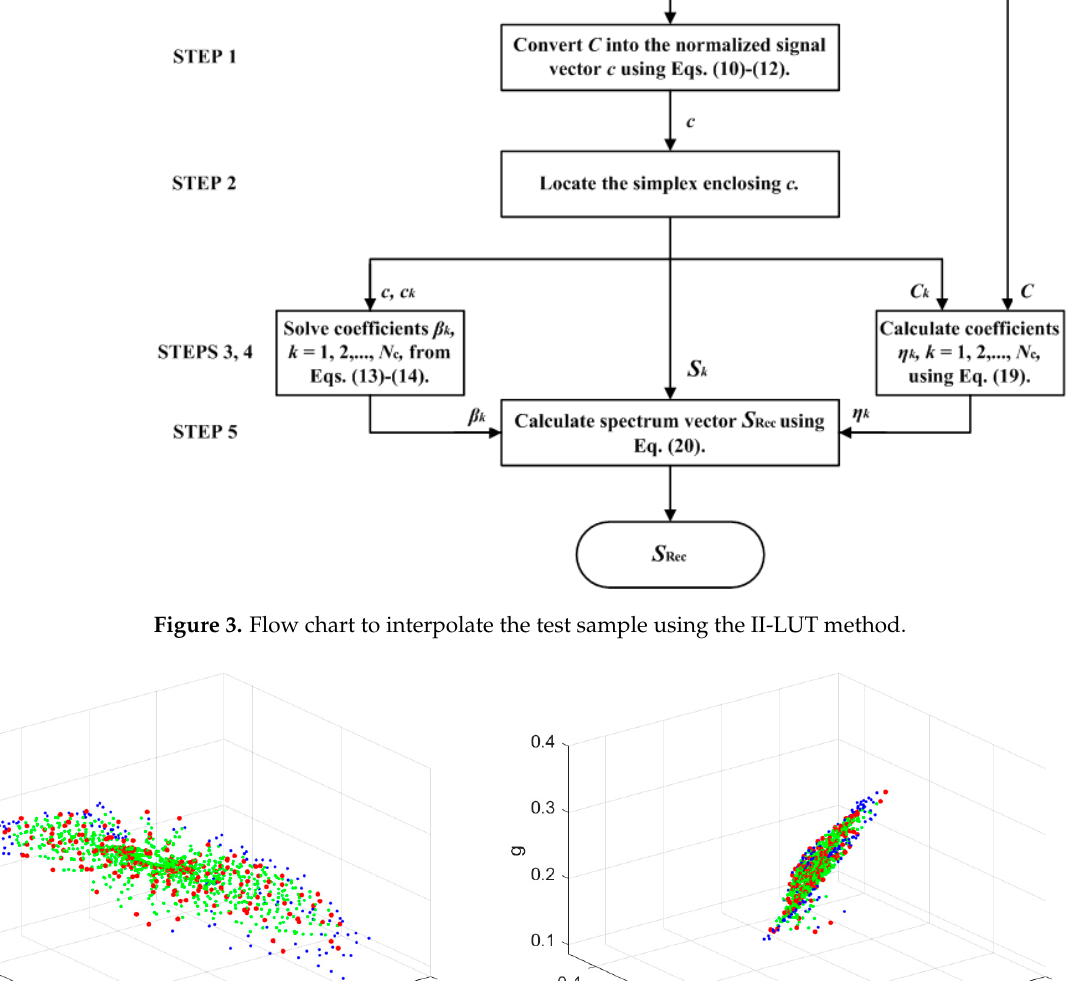
Figure 5. ( a ) The convex hull of the reference samples in the rgb normalized signal space for the RGBF camera. Reference and outside samples are shown with red and blue dots, respectively. ( b ) The same as ( a ) except for viewing angle. 3.5. Extrapolation The outside samples of the ID-LUT and II-LUT methods were extrapolated using the reference samples and ARSs. ARSs are measured using appropriately selected color filters and color chips so that they are highly saturated. The color filters are called the ARS filters. The extrapolation process is the same as the interpolation method shown in Sections 3.3 and 3.4 but using the expanded reference samples including the ARSs. The same cyan, magenta, yellow, red, green, and blue ARS filters and reference color chips as in [34] were adopted to extrapolate the cases using the D5100 and RGBF cameras. All outside samples can be extrapolated using the ID-LUT and II-LUT methods utilizing the reference samples and ARSs. The convex hull of the ARSs in RGBF signal space cannot be plotted due to its 4D geometry. The number of the ARSs in the convex hull is 126. The color points of these ARSs in the RGB, GBF, BFR, and FRG signal space were shown in [34]. Figure 6a,b show